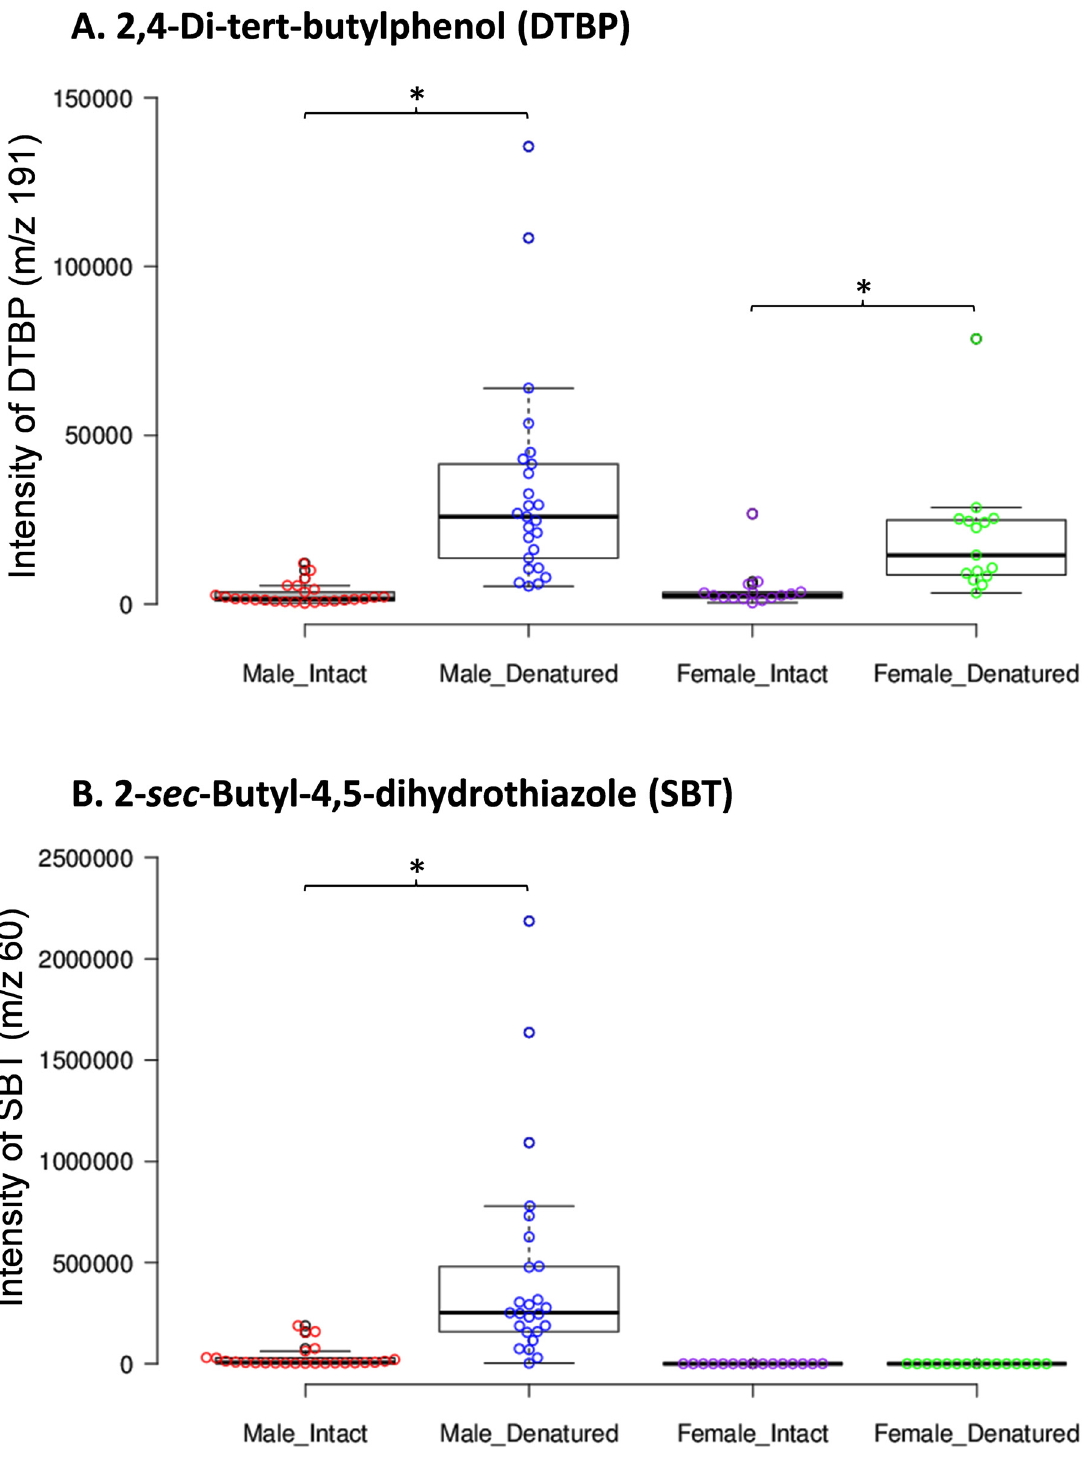
Fig 2. The release of DTBP (A) and SBT (B) upon denaturation of male and female mouse urine samples by addition of GdmCl. The box plots were created online using the BoxPlotR application [ 18]; http://boxplot.tyerslab.com/ * P (cid:1) 0.01 (Mann – Whitney test).